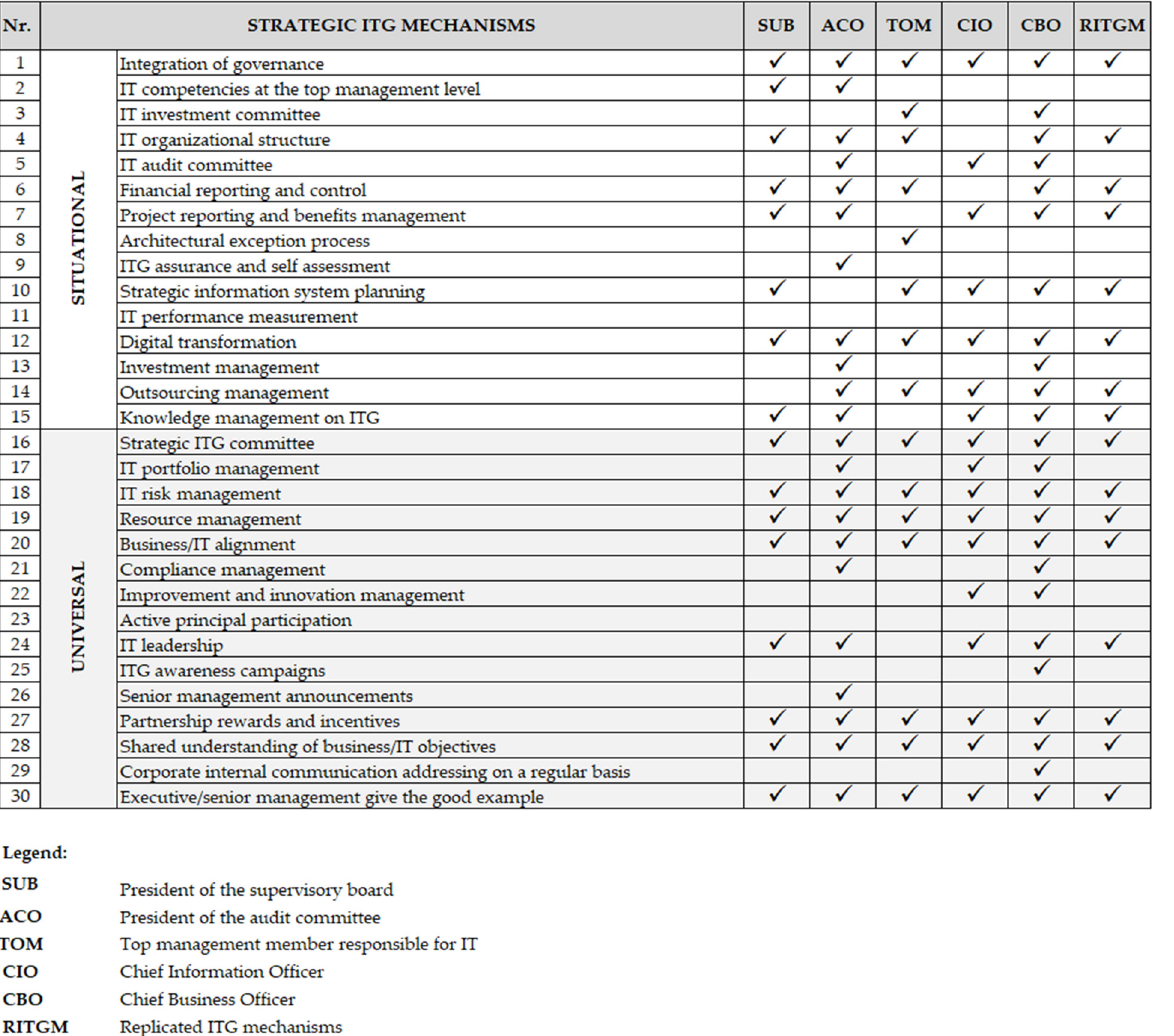
Figure 2. Situational and universal ITG mechanisms .